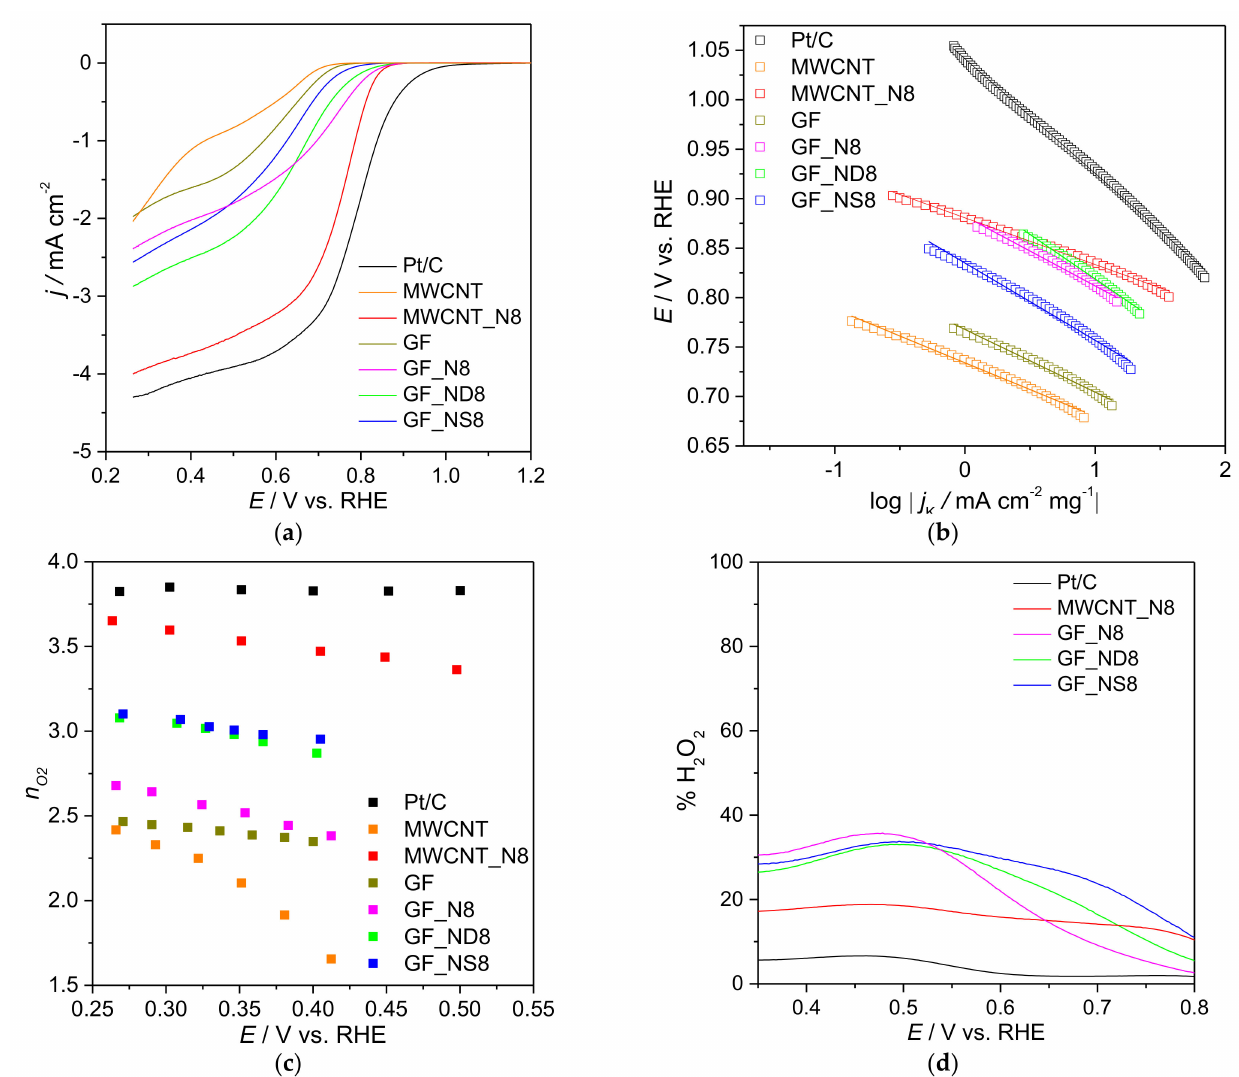
Figure 7. ORR LSV curves obtained in KOH (0.1 mol dm − 3 ) saturated with O 2 for Pt/C, MWCNT, MWCNT_N8, GF, GF_N8, GF_ND8, and GF_NS8 at 1600 rpm and 0.005 V s − 1 ( a ), the corresponding ORR Tafel plots ( b ), n O at several potential values ( c ), and the estimated percentage of H 2 O 2 2 produced ( d